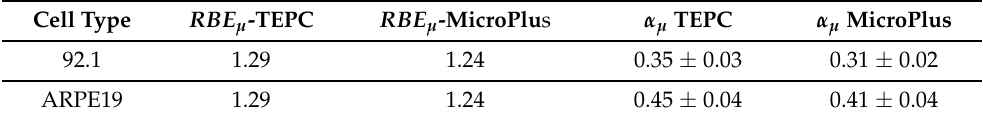
Figure 2. The microdosimetric spectra yd ( y ) measured at the entrance ( top ) and at cell position ( bottom ) acquired with the mini-TEPC ( left ) and with the MicroPlus Bridge microdosimeter ( right ). The thick grey line represents the biological weighting function r ( y ) (Loncol, 1994). The red curves are the weighted distributions yr ( y ) d ( y ). The black curves are the experimental microdosimetric spectra. See text for more details. Table 2. RBE µ calculated from microdosimetric spectra, and corrected by a constant factor to have RBE µ = 1.1 in entrance. The parameters α µ TEPC and α µ MicroPlus were calculated with Equations